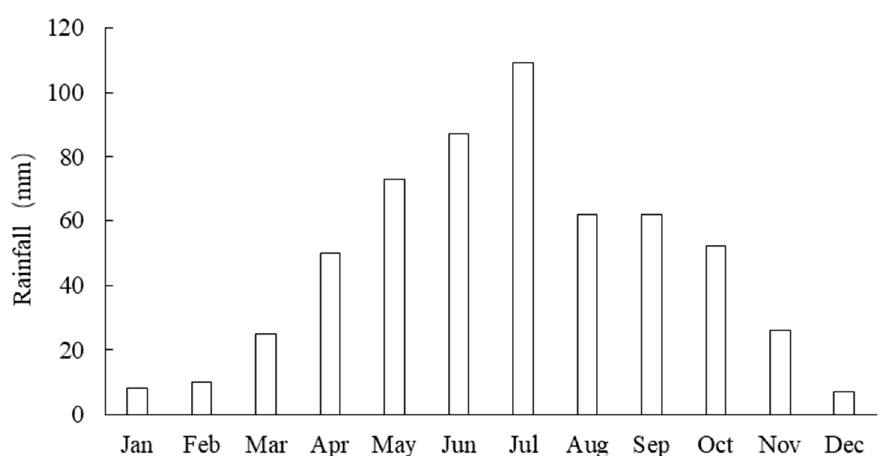
Figure 3. Long-term monthly mean rainfall (1990–2020) in Chongqing.